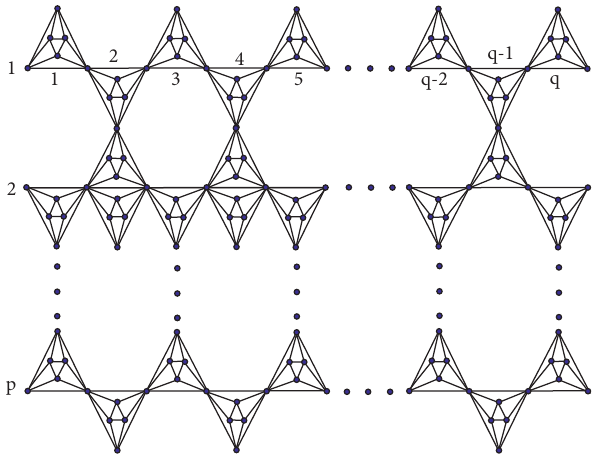
Figure 1: Third-type chain hex-derived network G 3